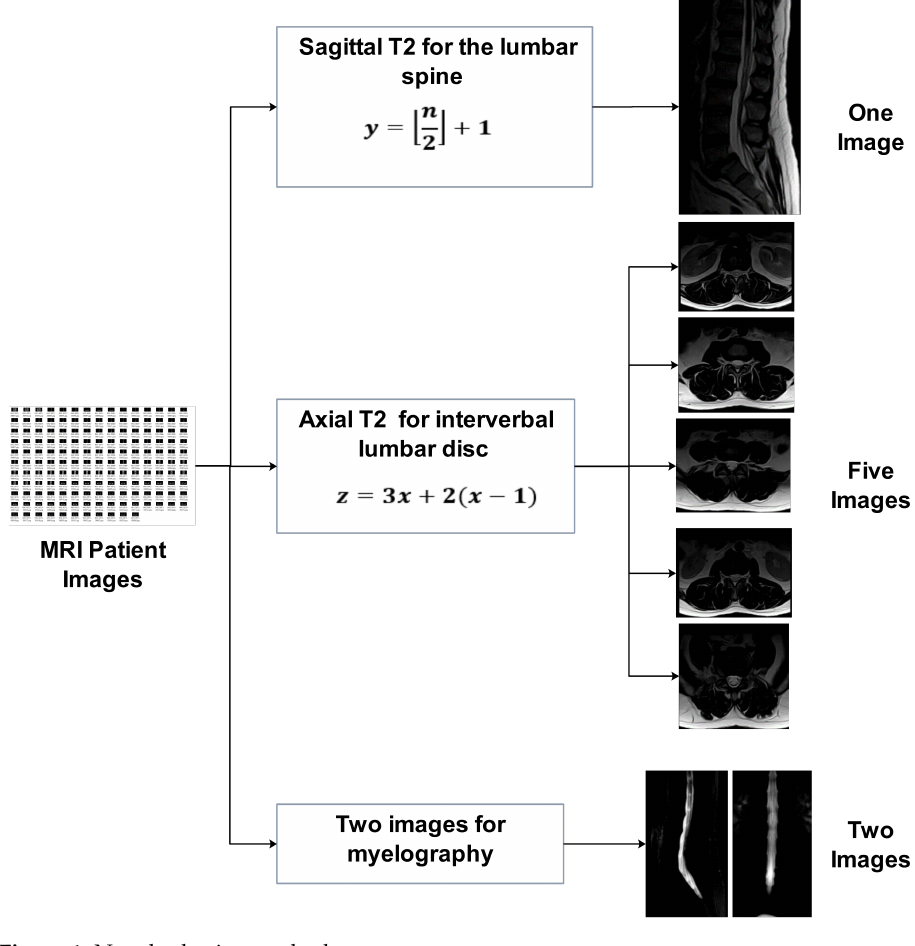
Figure 1. Novel selection